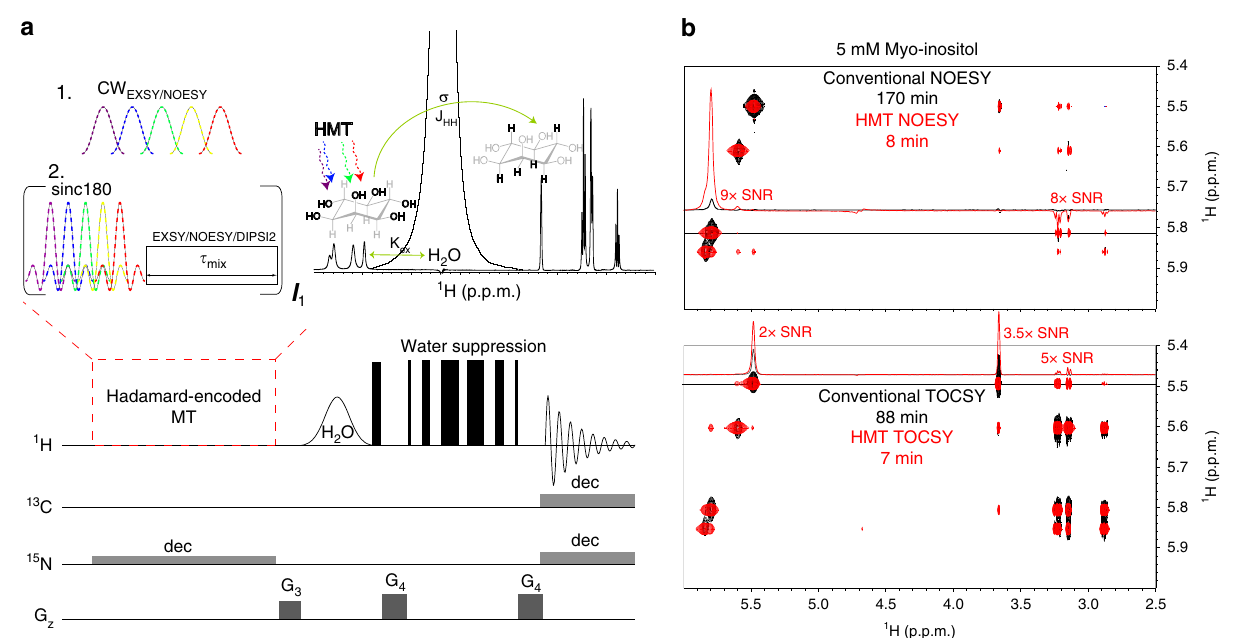
Fig. 1 Hadamard-encoded magnetization transfer sequences. a HMT pulse sequence illustrating the two types of perturbation procedures utilized here for improving the ef fi ciency of homonuclear 2D correlations involving labile sites. These were Hadamard-encoded selective polychromatic saturations, or looped Hadamard-encoded polychromatic inversions (assumed here imparted by sinc pulses) followed by a delay for NOESY/EXSY transfer or by DIPSI2 13 to achieve TOCSY ’ s isotropic mixing (selective saturations can be used only for the NOESY/EXSY transfers; repeated inversions work for all). During these long MT processes, illustrated here for myo-inositol, a three-way polarization transfer is effectively established, where water constantly repolarizes the targeted labile 1 Hs, enabling a prolonged magnetization transfer to the non-labile counterparts. “ dec ” refers to GARP4 68 or adiabatic 69 decoupling used during the encoding and the acquisition for labeled samples; water suppression was achieved using excitation sculpting 70 or WATERGATE 3919 71,62,63 schemes. b Comparisons between conventional NOESY (80 ms mixing) and TOCSY (48 ms DIPSI2 mixing) spectra acquired on myo-inositol, and Hadamard MT counterparts (NOESY obtained using 800 ms CW mixing; TOCSY with 12 loops of 24 ms DIPSI2 mixing). Note the different acquisition times required ( ≈ 10 – 20× faster in the HMT scheme), and the substantial (2 – 9×) enhancements of the cross- and diagonal peaks. Spectra were acquired at 600 MHz on a Bruker Avance III spectrometer equipped with a Prodigy